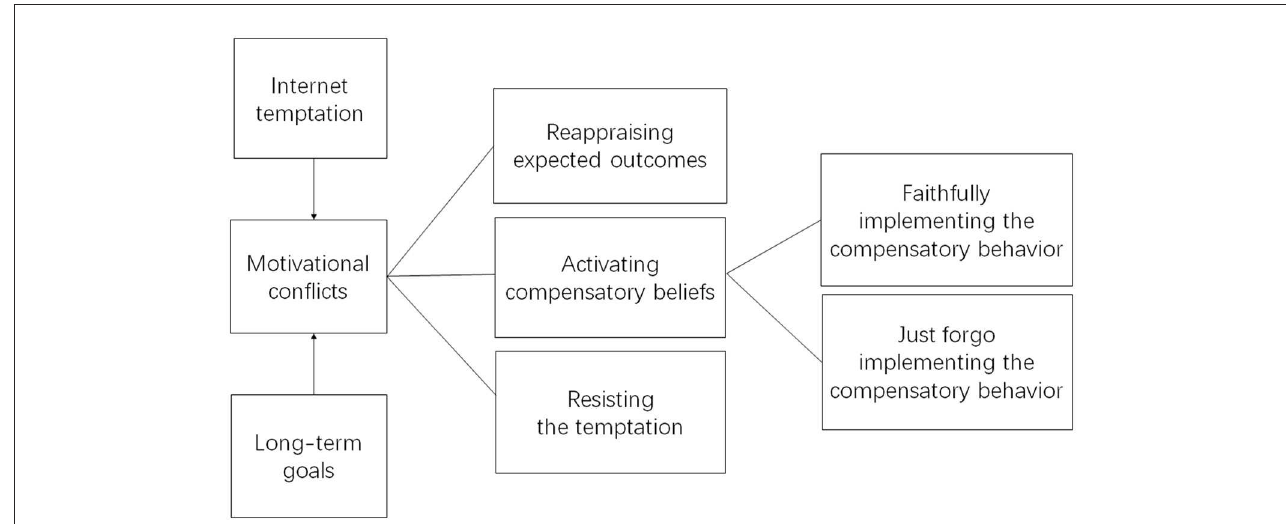
FIGURE1 The compensatory belief model for internet gratification